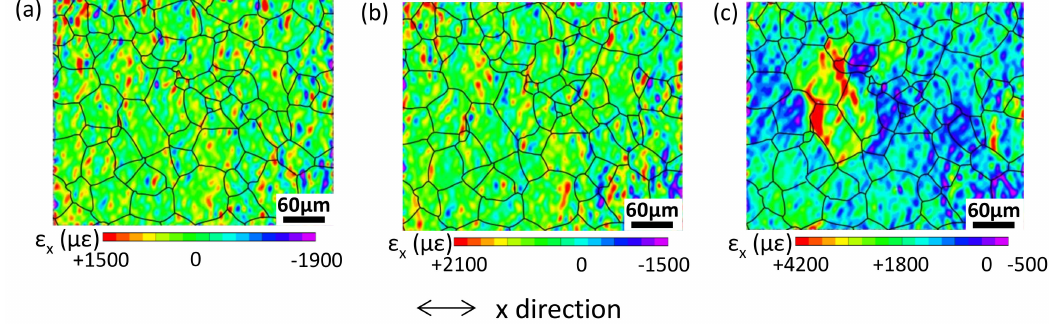
Figure 6. Two-dimensional strain contours with grain boundaries at the applied stresses of ( a ) 26 MPa, ( b ) 128 MPa and ( c ) 307